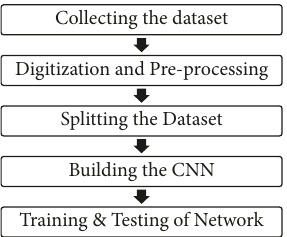
Figure 1: Research